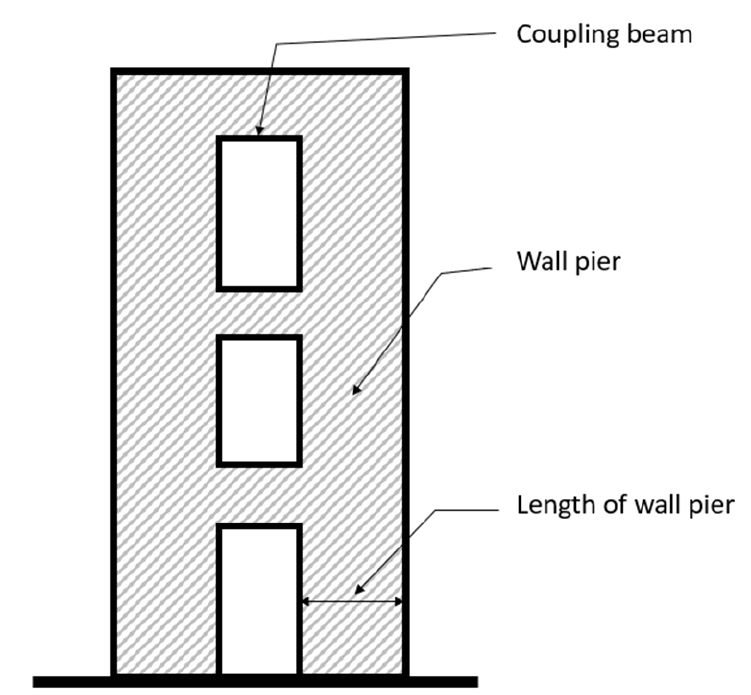
Figure 4. Coupled Shear Wall. (Sketch by K. Al-Kodmany).